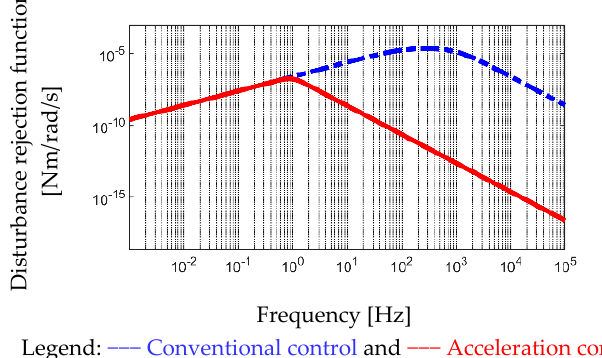
Legend: −−− Conventional control and −−− Acceleration control Figure 12. Comparison of disturbance rejection function | θ L (s)/T L (s)| between conventional control in (11) and acceleration control in (12).